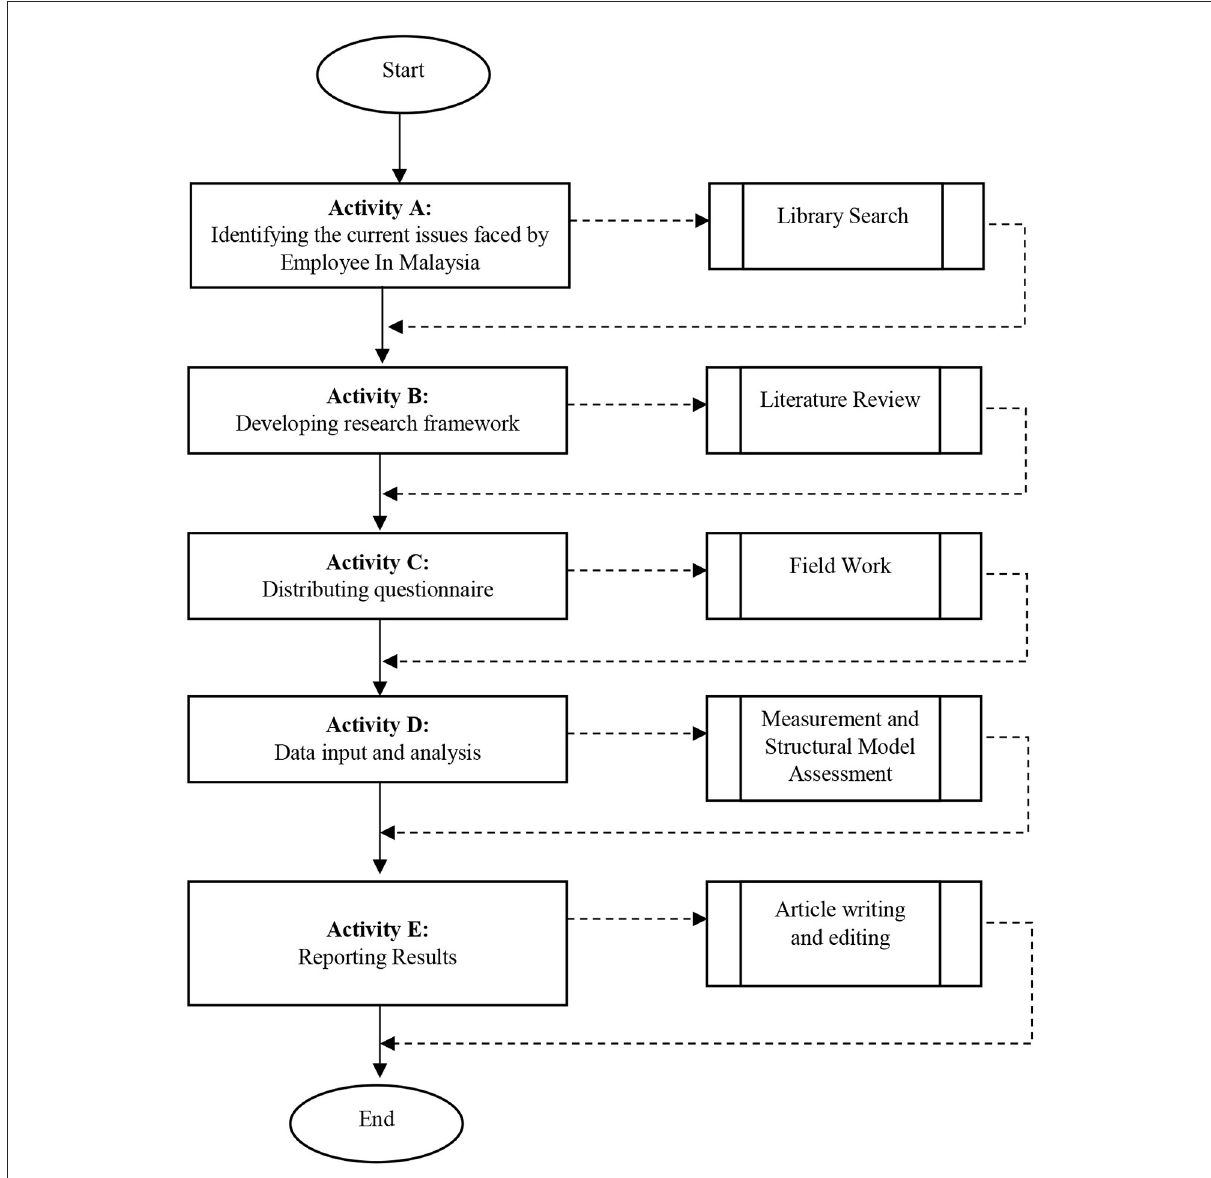
FIGURE2 Flowchart of research